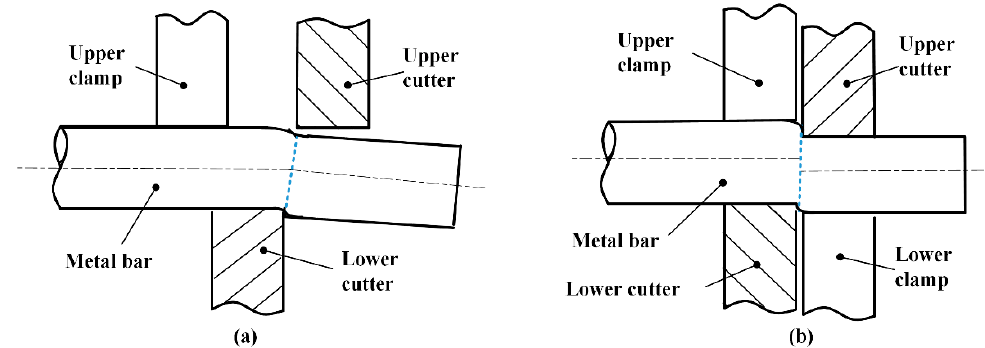
Figure 1. Schematic of different cropping methods. ( a ) Industrial cropping method. ( b ) The high-speed shearing method with radial constraint.